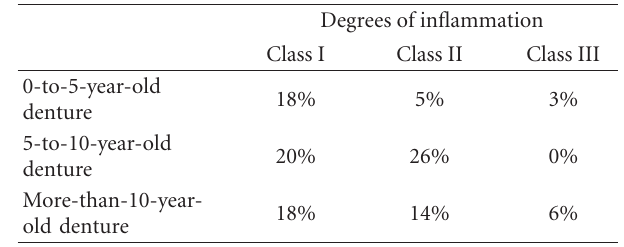
Table 2: Relation of denture age to